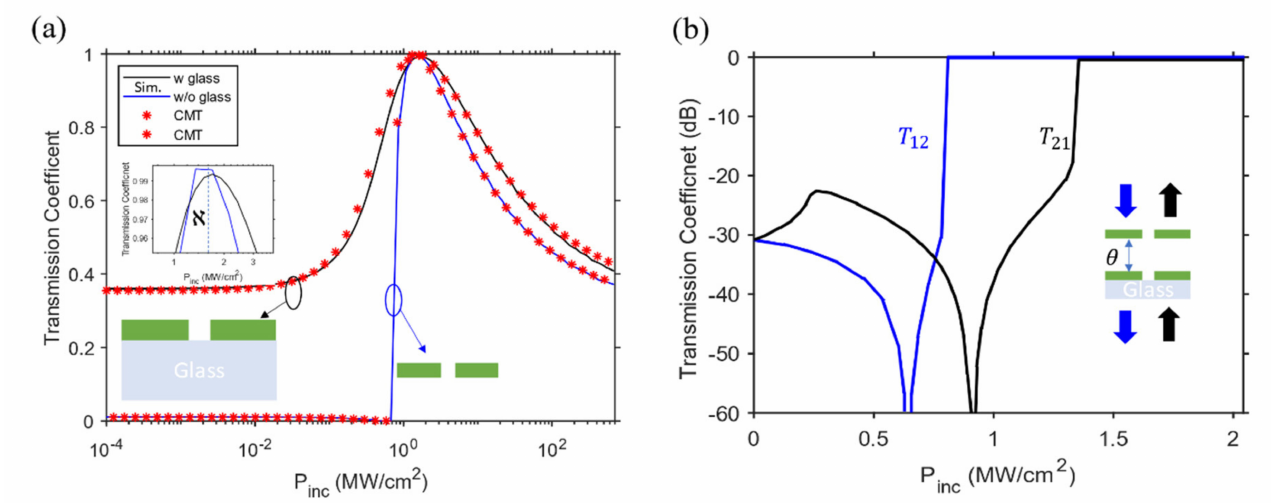
Figure 7. Full wave simulation results for excitation at frequency c/1.56104 [um], with a normally incident plane wave of power P inc . ( a ) Nonlinear transmission for isolated gratings as a function of the input power. The red markers indicate the results obtained using the CMT standard model with the parameters given in Table 3 (see Section 5.5 (Fano Resonator Parameters)). ( b ) Transmission for the coupled metasurface design with θ = 6.4 π shown in the inset. T 12 indicates the transmission from top to bottom, while T 12 indicates the transmission from bottom to top. The NRIR is 2.1 dB, and the peak forward transmission is − 0.2